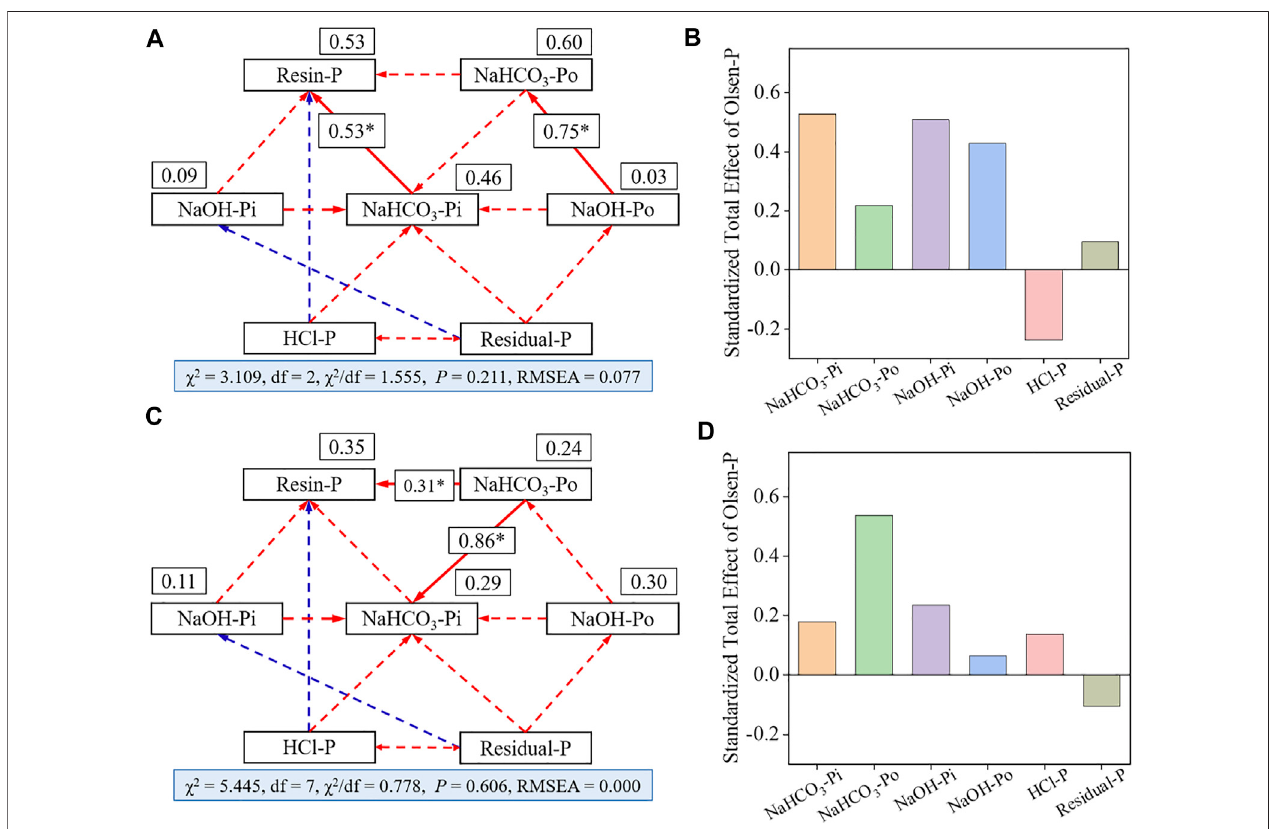
FIGURE 4 | Structural equation modeling (SEM) analysis of different P fractions transformation under P fertilizer input and optimization on four-year rice-wheat rotation paddy fi eld from 2016 to 2020.